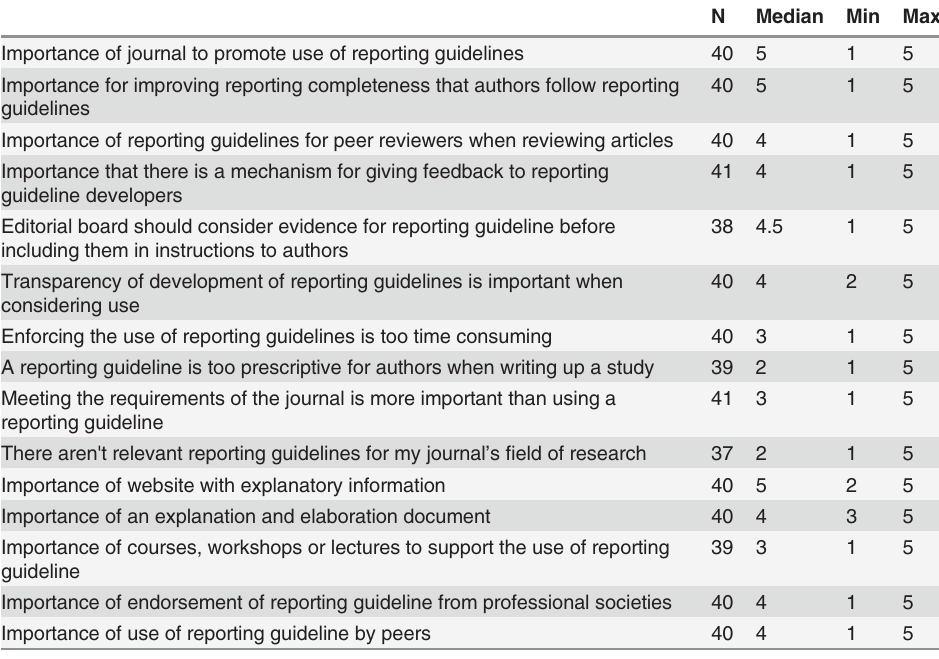
Table 1. Editors ’ Level of Agreement with Statements Relating to Use of Reporting